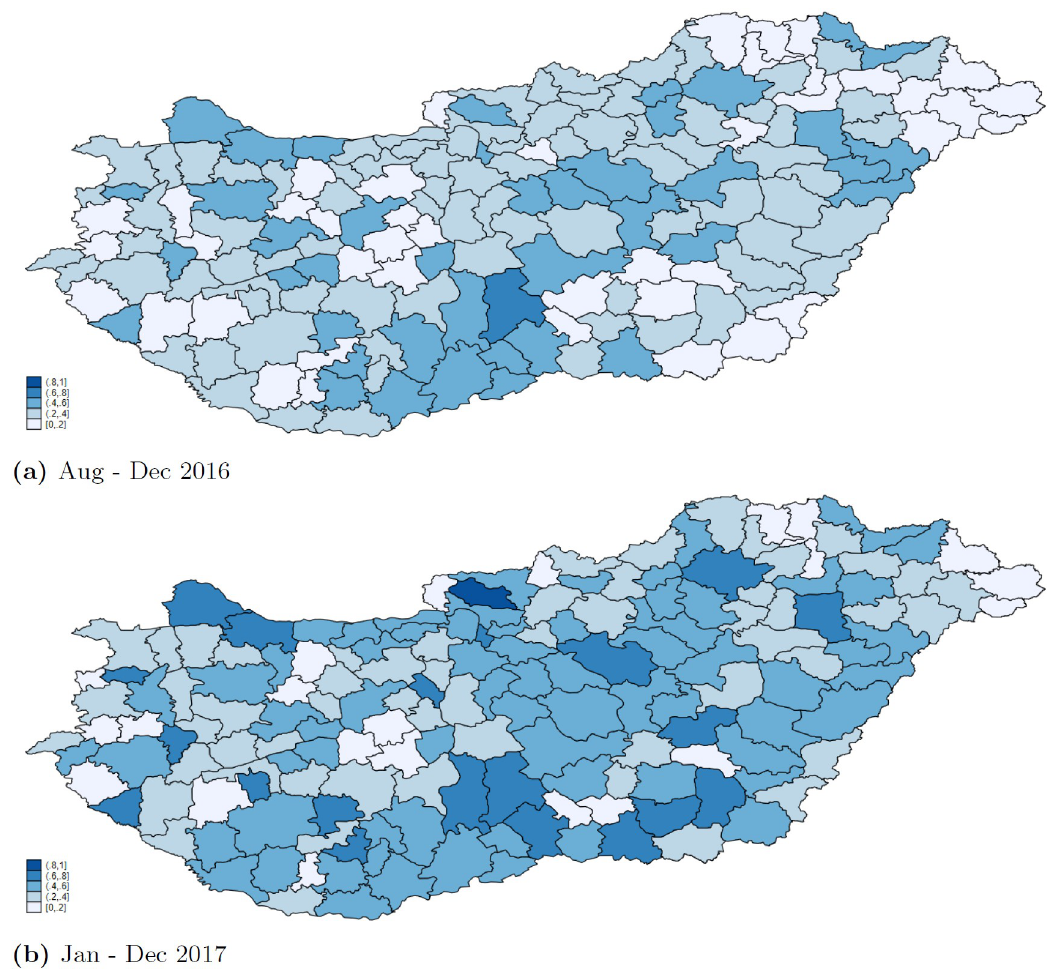
Fig 4. Regional variation in prescription patterns. Fraction of antibiotic prescriptions (measured in DOT) prescribed in line with the new guidelines by micro regions, patients aged 0-4.